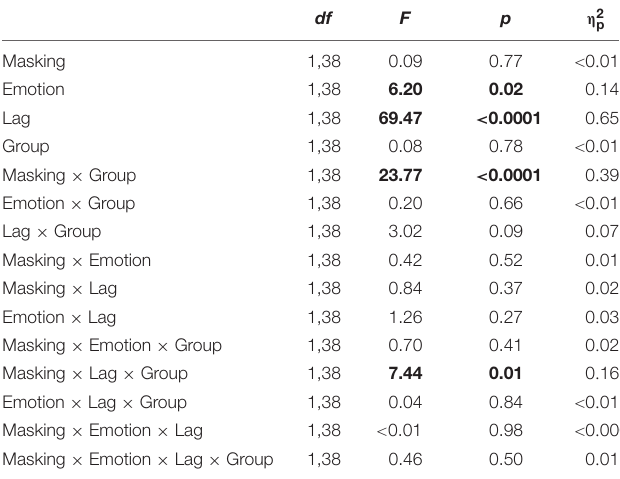
TABLE 4 | ANOVA results joint analysis Experiments 1 and